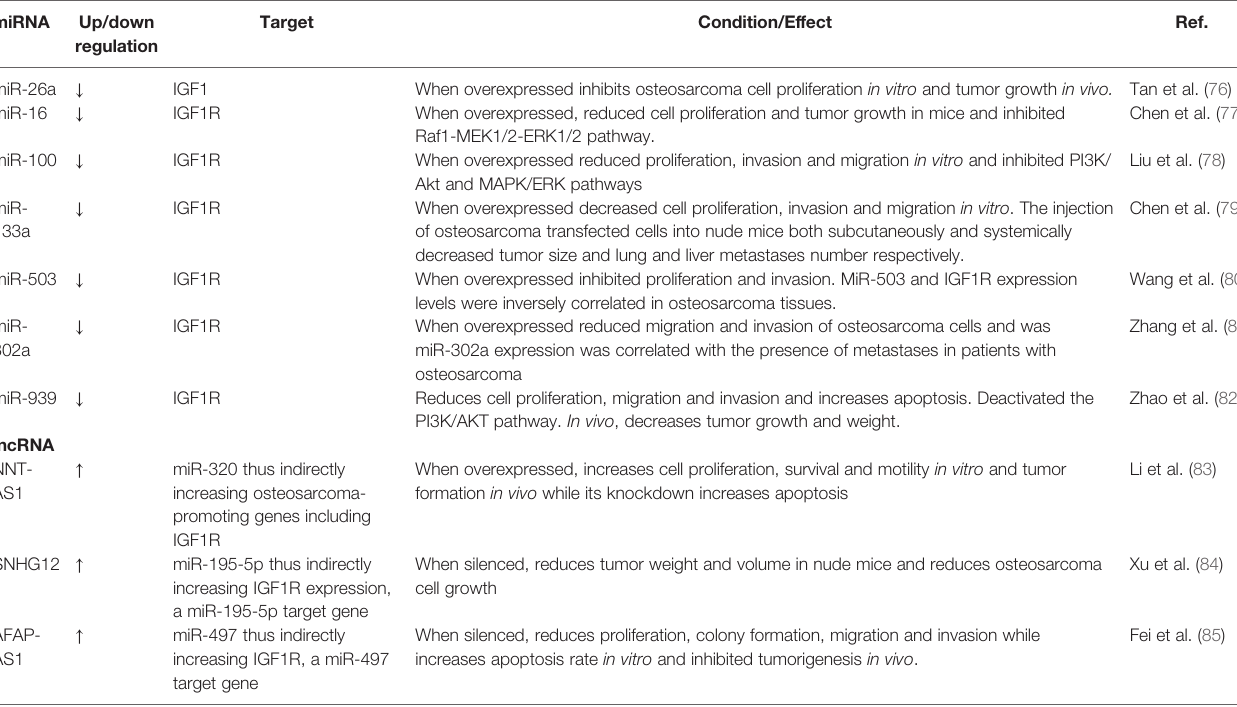
TABLE 2 | Current knowledge on the role of miRNAs and lncRNAs on the GH/IGF1 axis and IGF system in osteosarcoma. miRNA Up/down